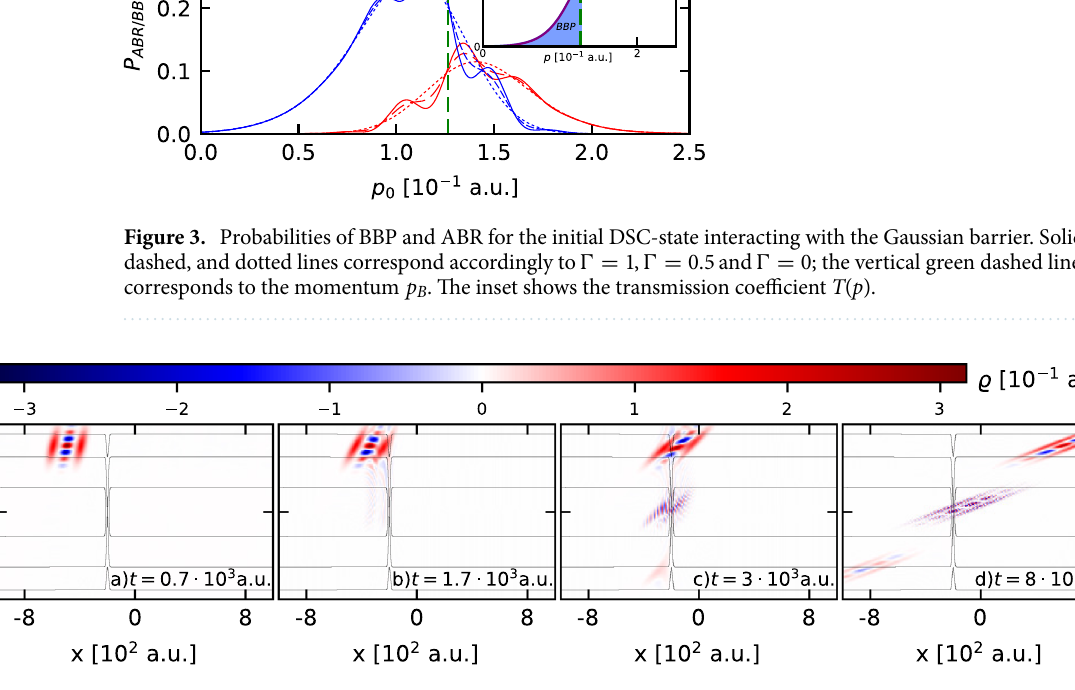
Figure 4. The phase-space snapshots of the DSC-state at different times during the interaction with the Gaussian potential barrier. The contour lines represent equipotential lines of the classical Hamiltonian for the considered